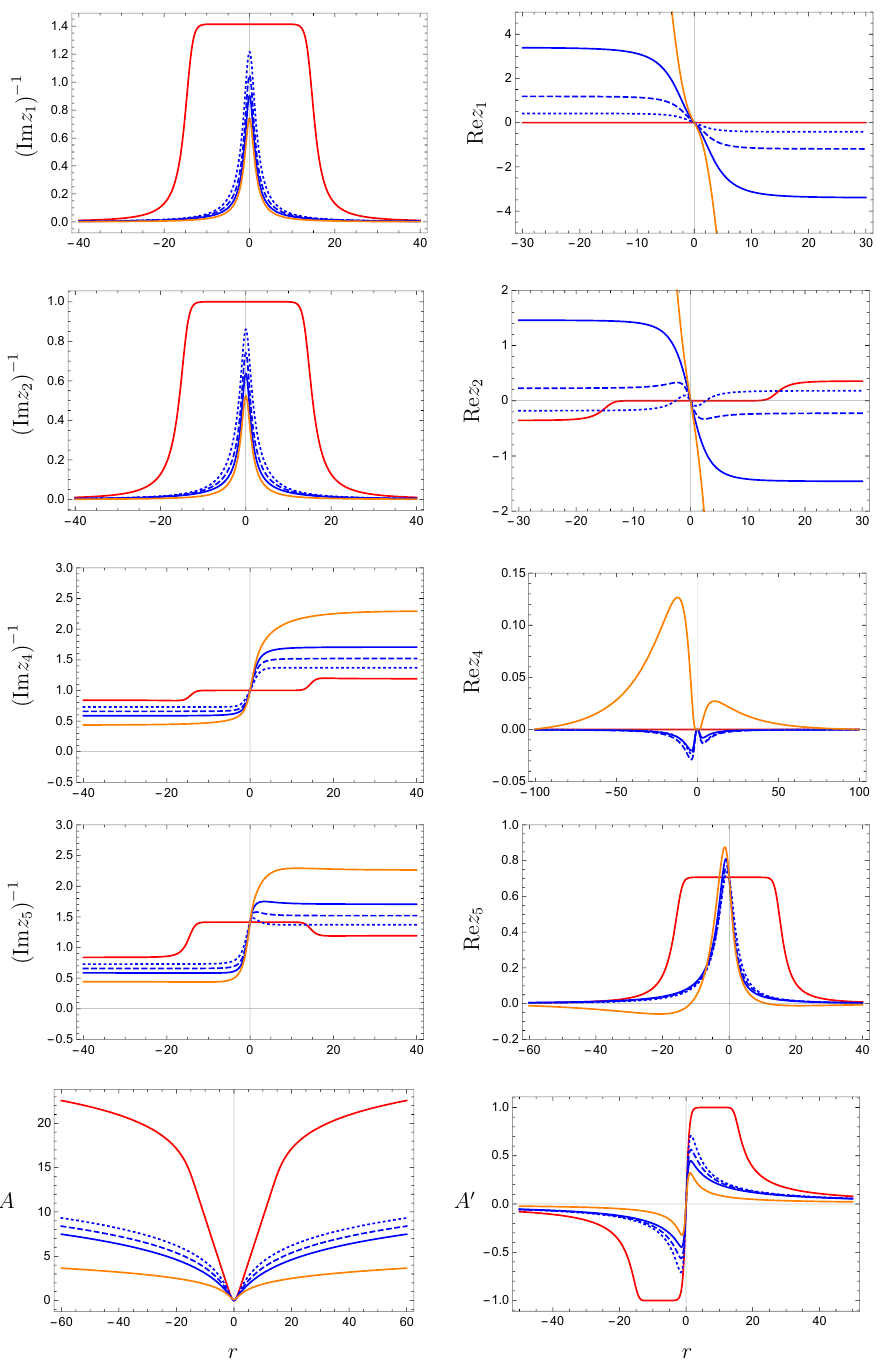
Figure 5 . Samples of regular flows within the SU(2) -invariant sector using the boundary condi- tions (3.30) for the complex scalar fields z